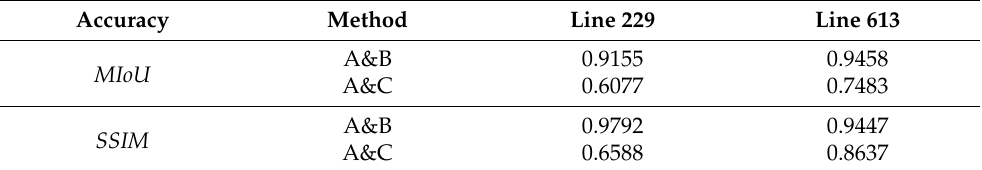
Table 2. The accuracy evaluation of predictions. Method A represents the visual interpretation, whose result is regarded as the standard. Method B and C are the DL-based identification and the FrangiV algorithm, respectively. Line 229 and Line 613 are the abbreviations of survey line